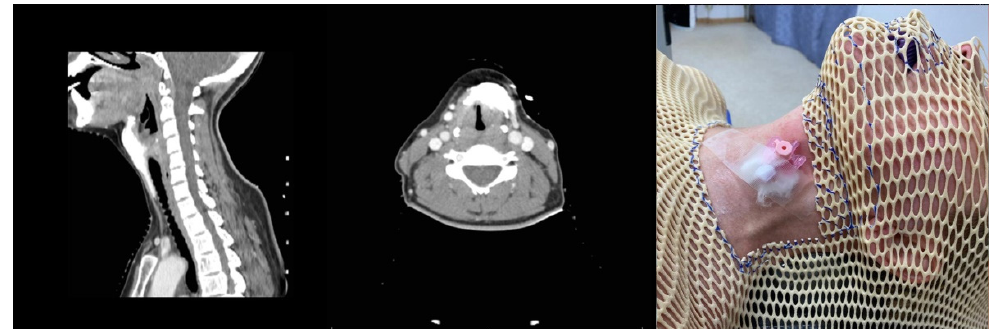
Figure 2. Cervical MSCT with intravenous contrast enhancement and cystography in the patient’s selected position, immobilized using a Q-fix system. Additional use of a bite splint installed between the central incisors to simulate the position of the lower jaw after intubation.